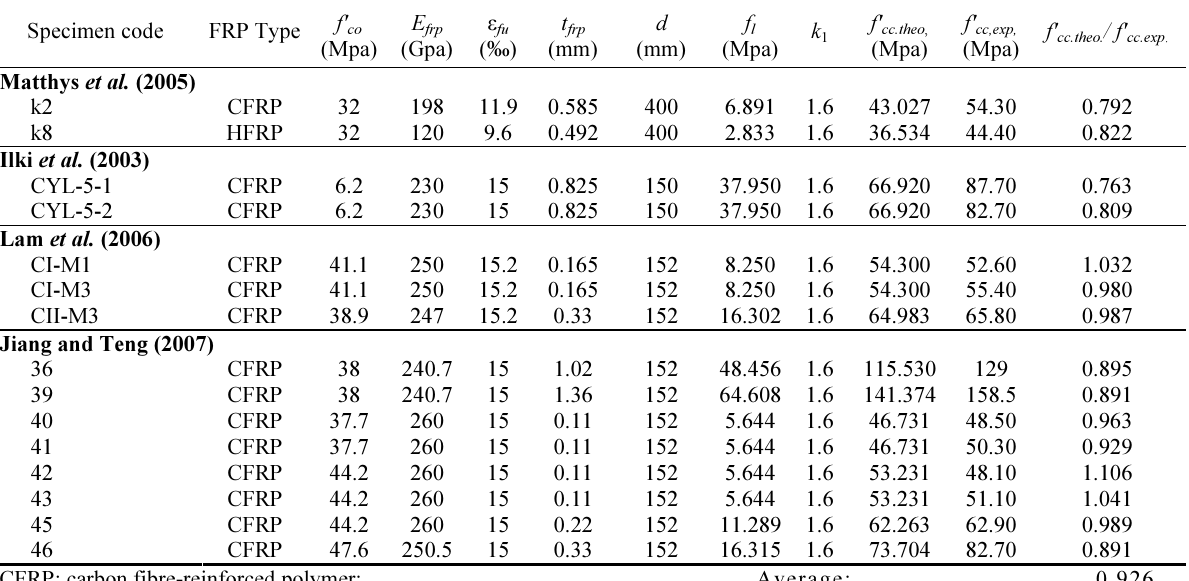
Table 6. Comparison of experimental and predicted results: compressive strength